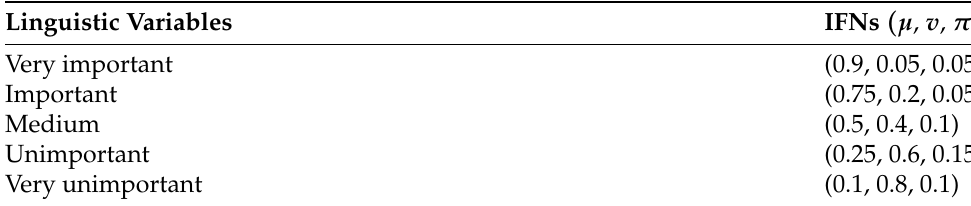
Table 2. Linguistic variables to evaluate the importance weights of decision makers